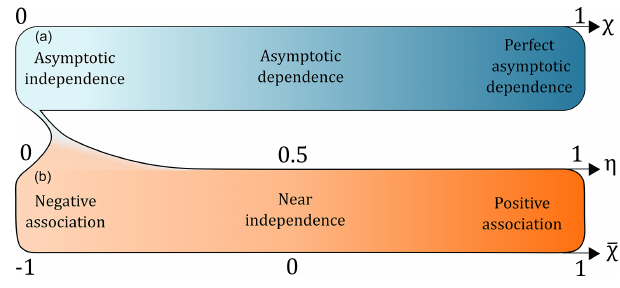
Figure 2. The three coefficients used in this study to assess the dependence between two variables at an extreme level. In the up- per part of the plot (blue), the coefficient χ varies between perfect asymptotic dependence (light blue; χ = 0) and asymptotic indepen- dence (dark blue; χ = 1). In the lower part of the plot (orange), which is in the asymptotic independence domain (in other words, χ = 0) the coefficients χ and η both vary between negative associ- ation (light orange; χ = − 1 ; η = 0) and positive association (dark orange; χ = η =